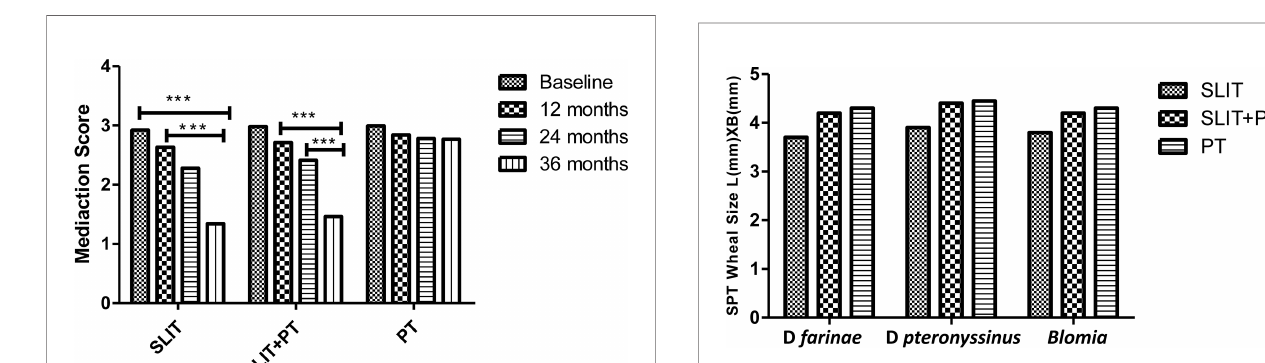
FIGURE 4 | Wheal diameter values of skin prick test (SPT) to house dust mite (HDM) across three treatment groups at